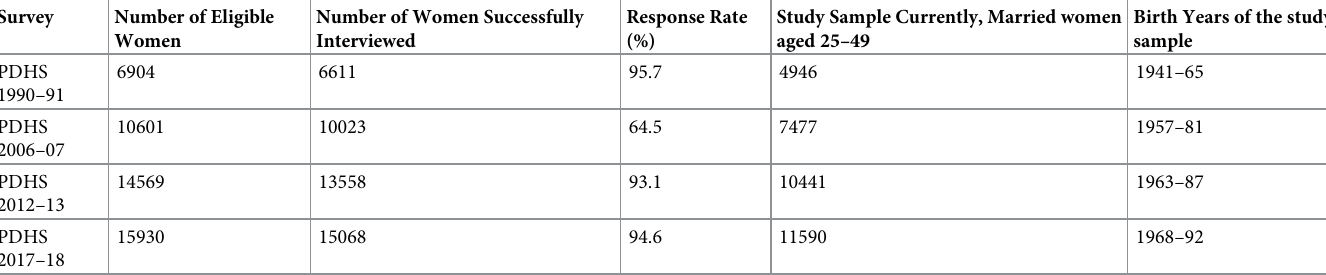
Table 1. Study Sample in all waves of Pakistan Demographic and Health Survey